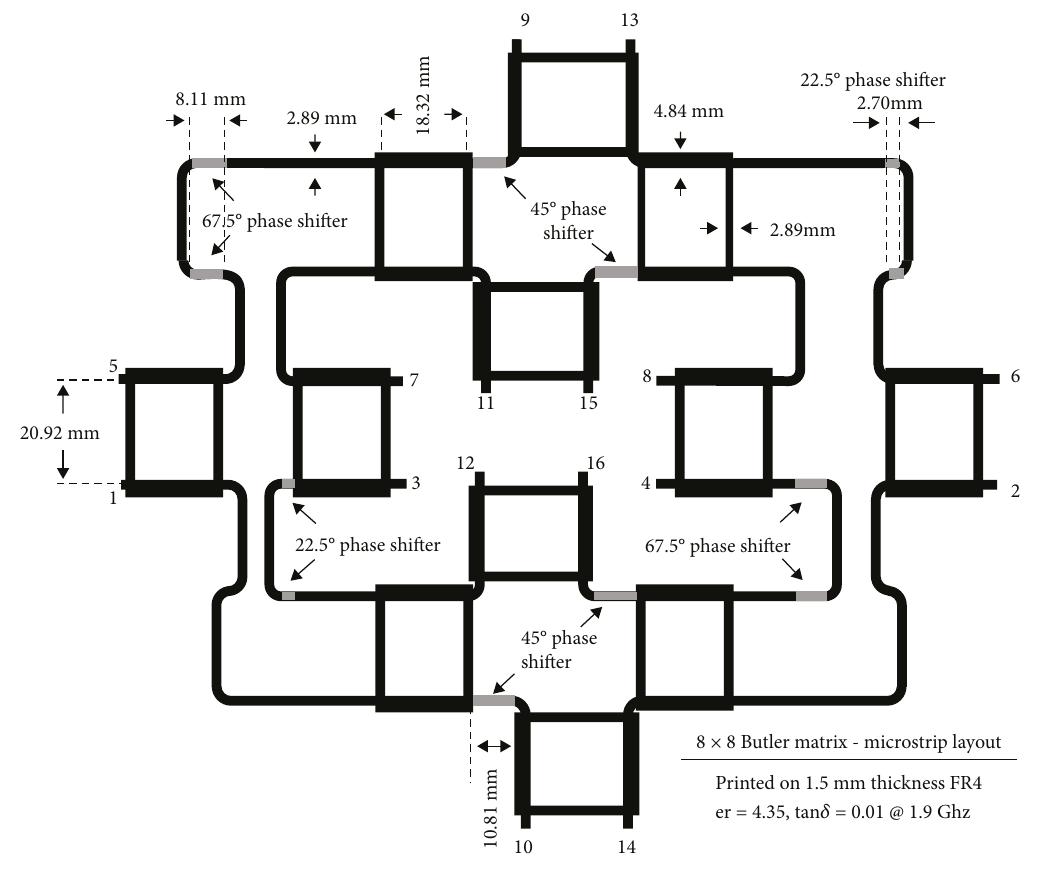
Figure 3: Layout of the designed 8 × 8 BM.